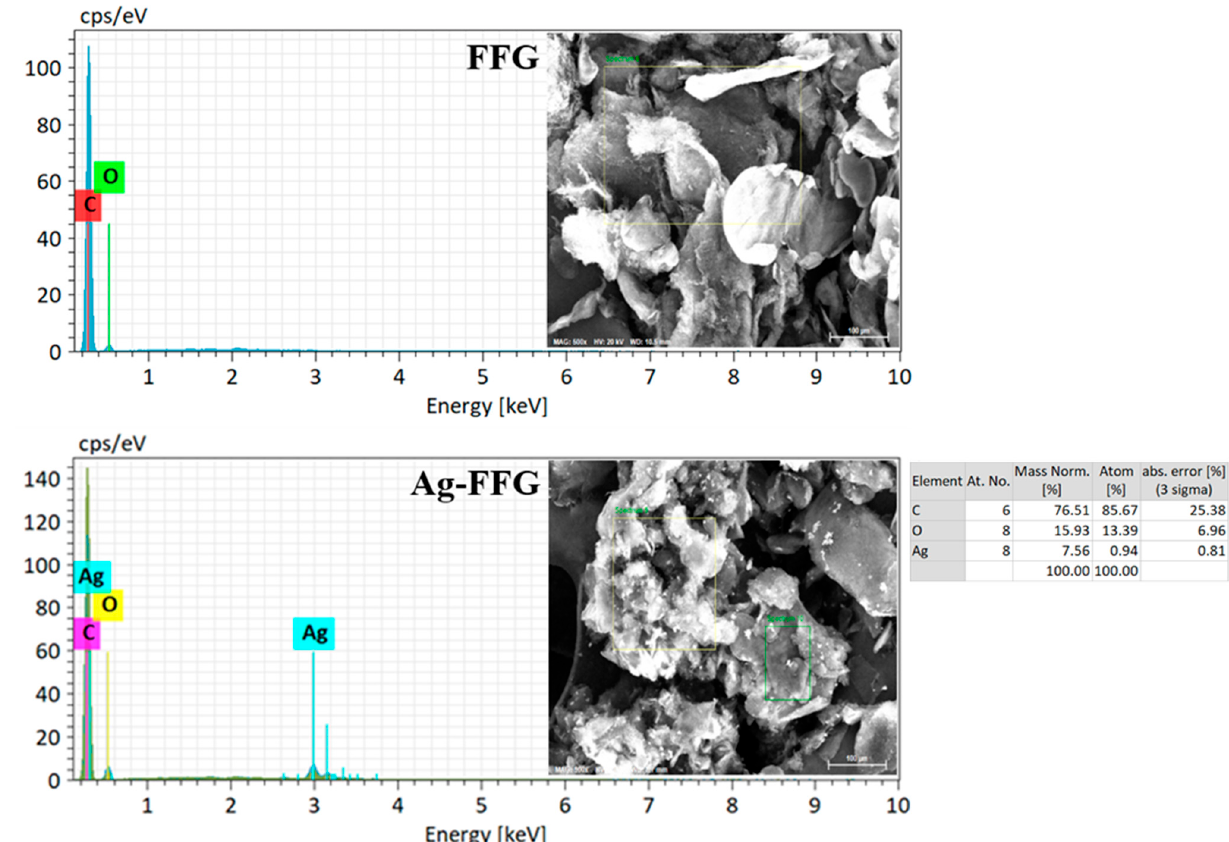
Figure 3. EDX spectra of FFG and Ag–FFG.